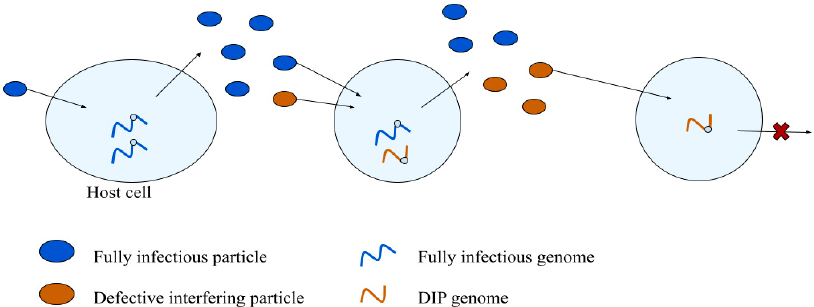
Figure 3. Defective interfering particles (DIPs): emergence and biology. DIPs arise from normal virus infections ( left ), and they amplify during cell co-infections with fully infectious particles ( middle ). DIPs alone are unable to productively infect cells ( right ).